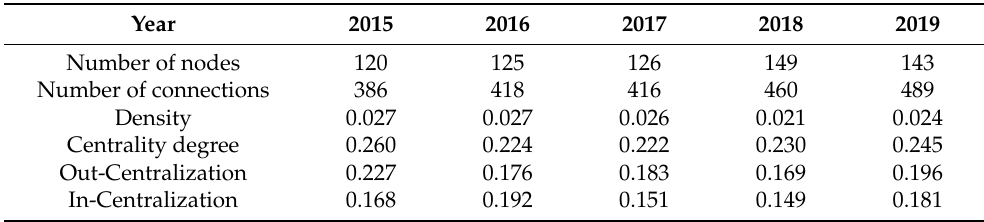
Table 3. Mean network level metrics in contemporary cruise port network of Southern Europe during the period 2015–2019.